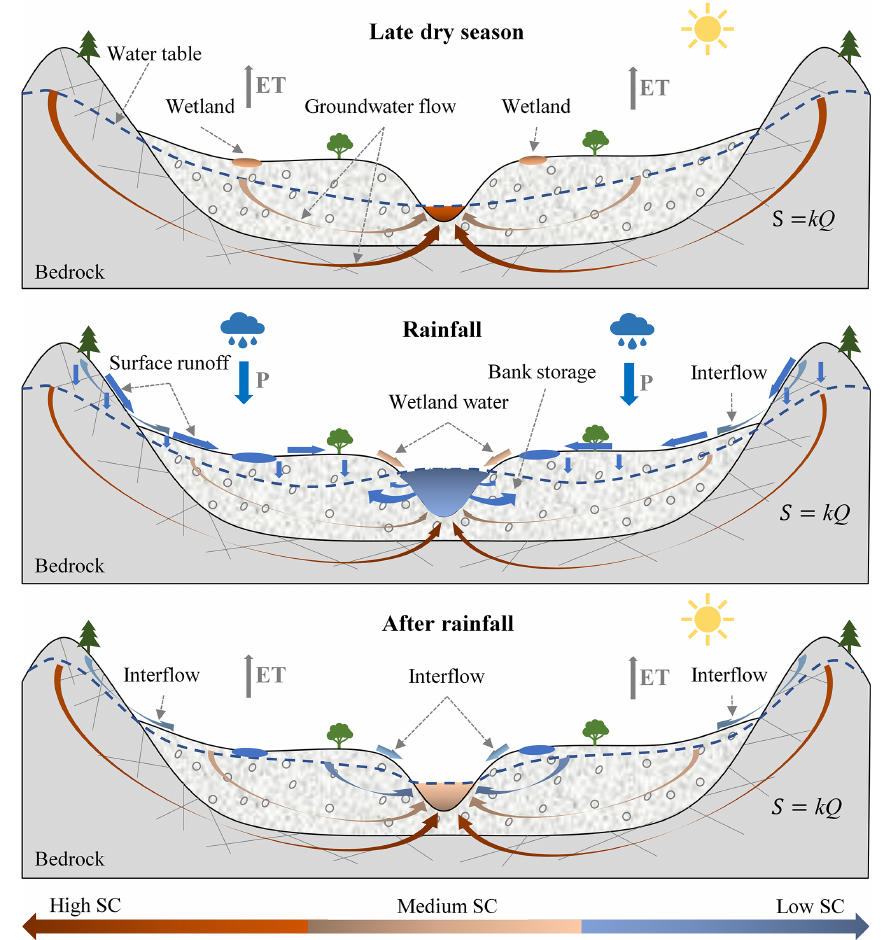
Figure 4. A conceptual diagram illustrating the influence of different transient water sources on streamflow over different periods. For the streamline arrows in the figures, color reflects the relative conductivity whereas width reflects the relative flow. The equation shown represents the linear reservoir model describing the relationship between groundwater storage ( S ) and discharge ( Q